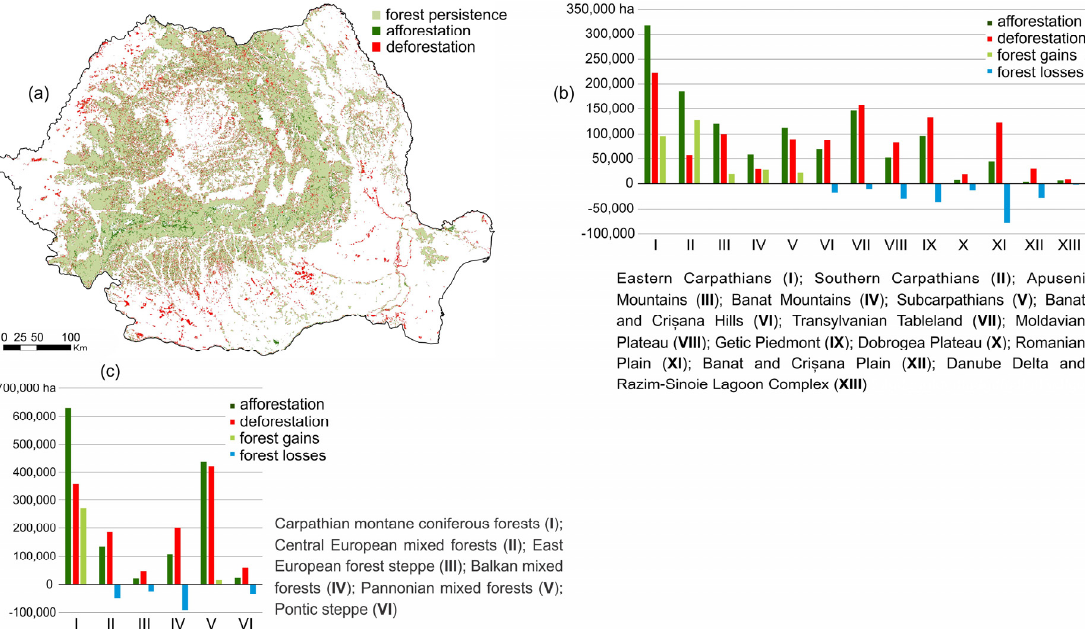
Figure 7. Simulated forest-cover dynamics for 2006–2050 ( a ), and the potentially change-affected areas at the major landform units ( b ) and the major vegetation ecoregions ( c ) (processed by